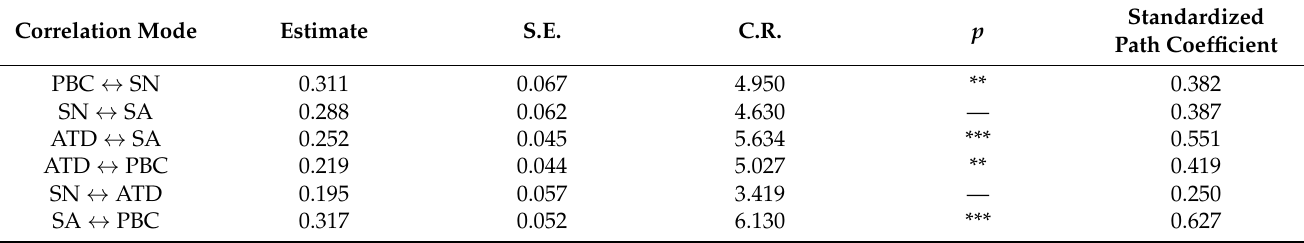
Table 4. Correlation coefficients and AVE square roots of latent variables.